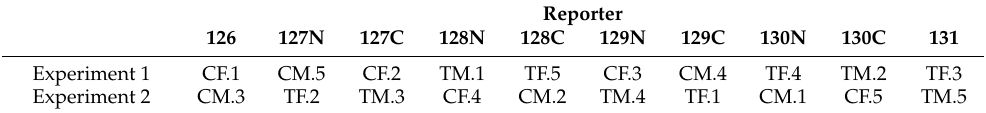
Table 1. Experimental design for the TMT10-plex labelling. Two experiments and ten labelling reactions were performed for a total of twenty samples randomly distributed to avoid labelling bias. Samples are identified as C (Ctrl), T (treated with HTX), sex (male M, female F), and number of the